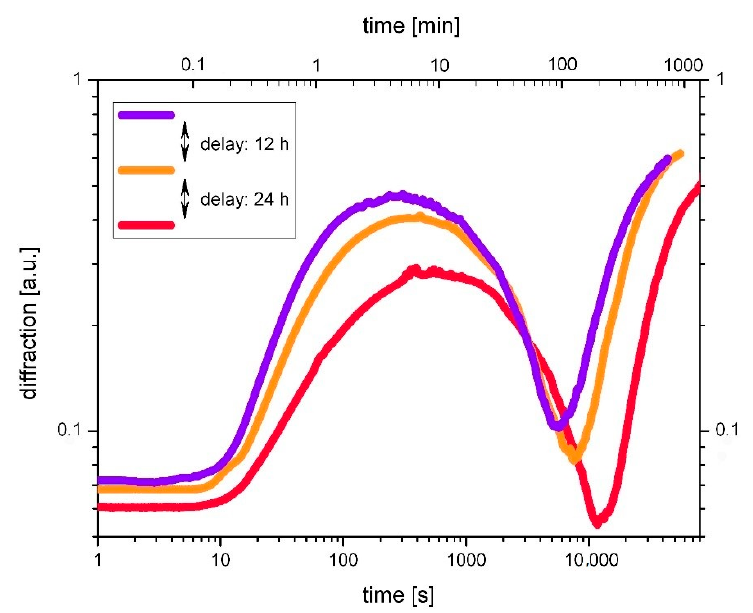
Figure 2. Impact of pre-exposure on the holographic grating growth in the doped system. Holograms were subsequently recorded in one sample with a time lag of 12 h. Exposure duration was 15 s for each hologram and the corresponding exposure dose was 750 mJ/cm 2 . The growth curves are displayed on double logarithmic scales to highlight the differences in the formation of the first (violet), second (orange), and third (red) grating.